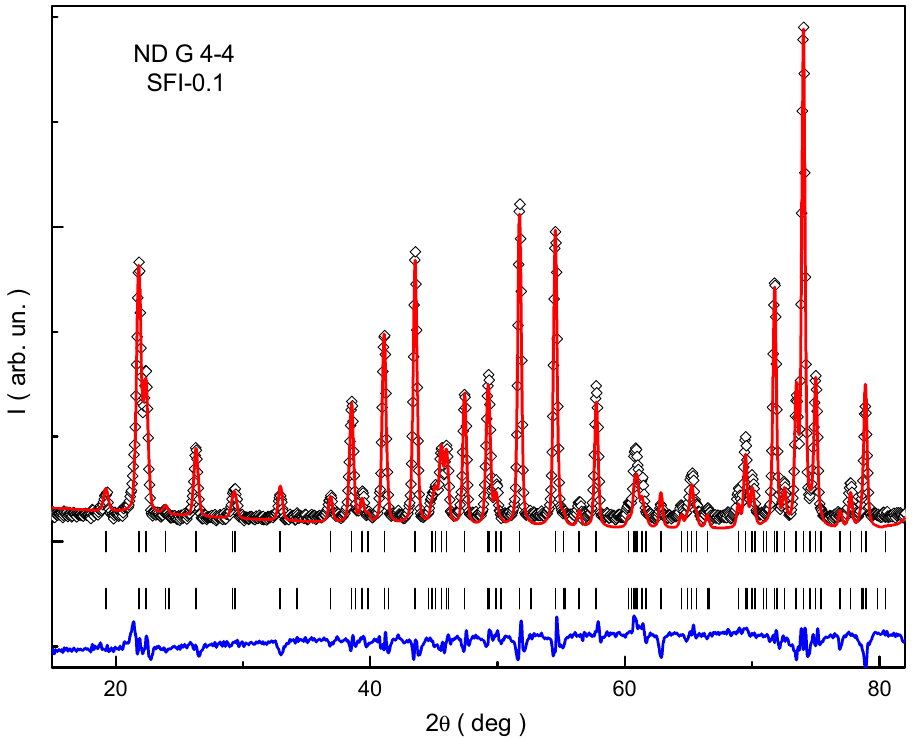
Figure 1. NPD pattern with Rietveld fitting lines at room temperature for the SFI-0.1 sample measured on diffractometer G